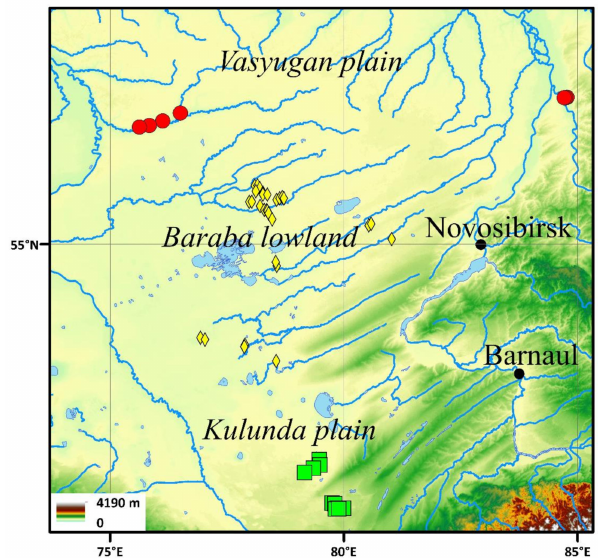
Figure 1. The layout of the studied small lakes in the south of Western Siberia. Symbols: Red circle—the Vasyugan plain lakes, yellow rhomb—the Baraba lowland lakes, green square—the Kulunda plain